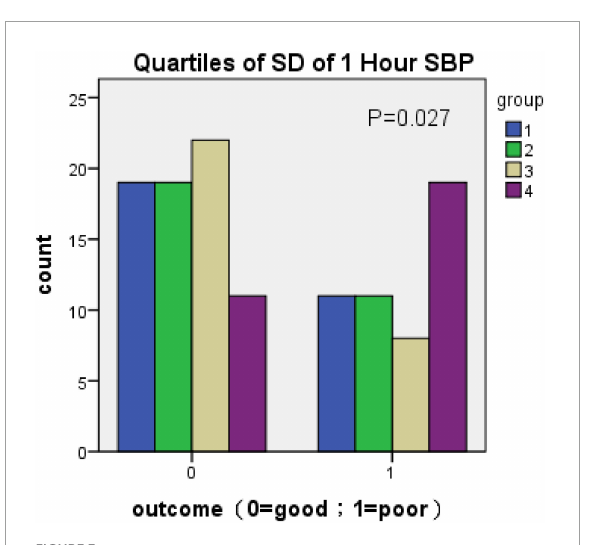
FIGURE4 Quartiles of SV of 24-h SBP (outcome: 0 = good; 1 =